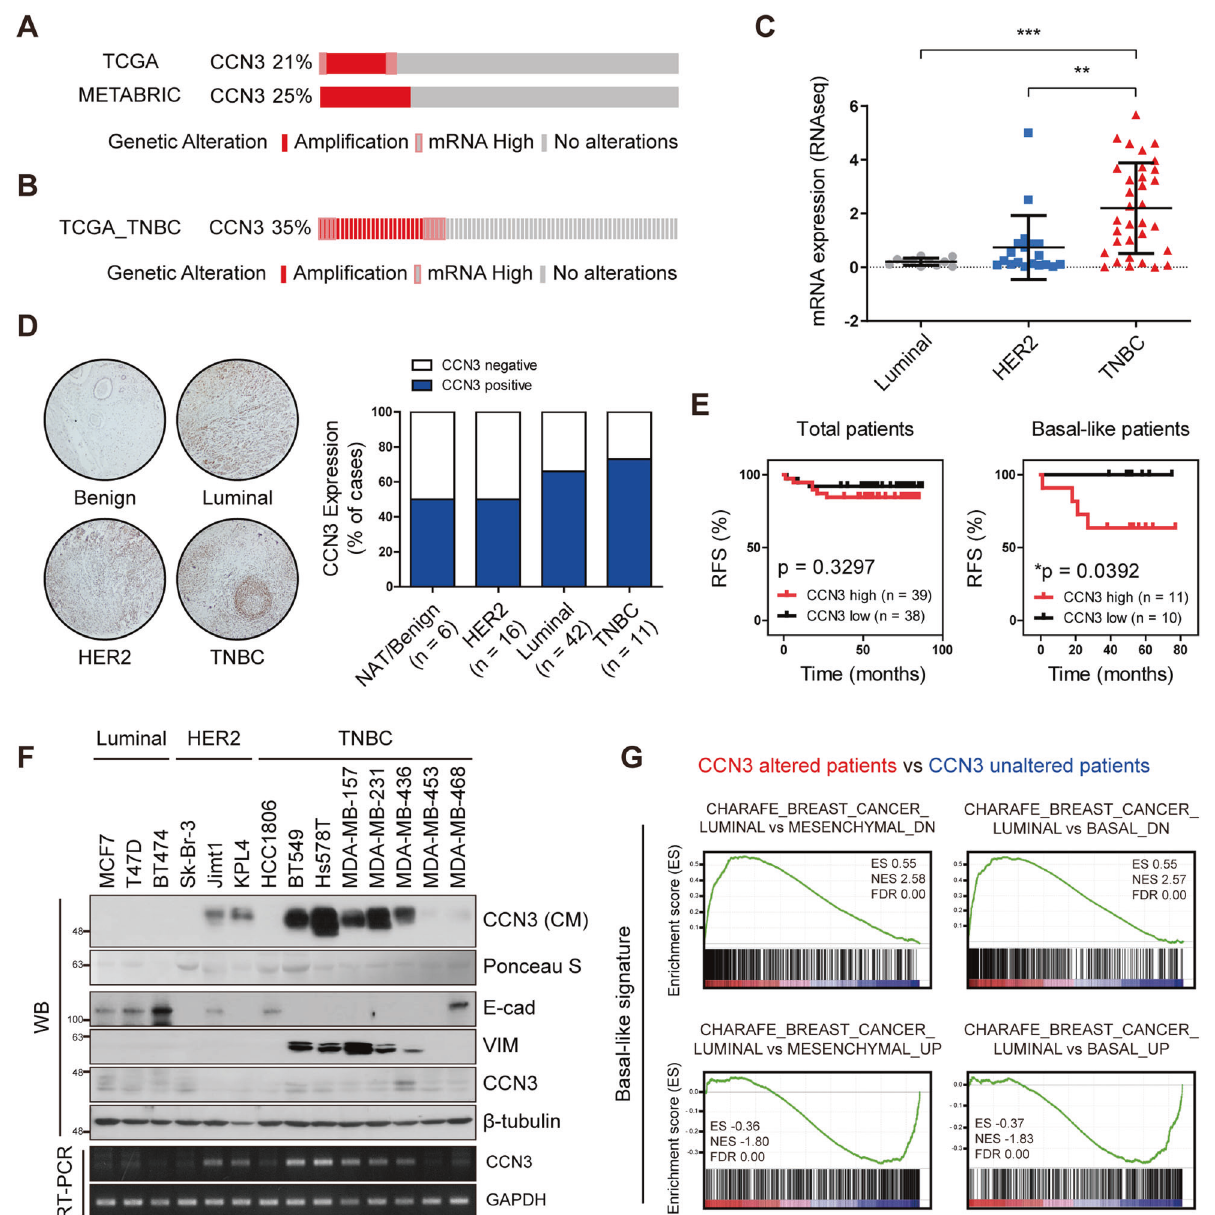
Fig. 1 CCN3 highly expressed in TNBC and correlates with basal-like phenotype. A Oncoprint of breast cancer patients with gene ampli fi cation and mRNA up-regulation of CCN3 from TCGA (Cell, 2015) and METABRIC dataset. B Oncoprint of triple-negative breast cancer patients with gene ampli fi cation and mRNA up-regulation of CCN3 from TCGA (Cell, 2015) dataset. C CCN3 mRNA expression of breast cancer cell lines. mRNA expression data were obtained from CCLE dataset. Expression values were clustered by breast cancer molecular subtype (luminal, n = 11; HER2, n = 19; TNBC, n = 33). P -values were calculated with one-way ANOVA with a post-hoc Dunnett ’ s multiple comparison test (* p < 0.05, ** p < 0.005). D Tissue array analysis of CCN3 expression with breast cancer patients. E Recurrence-free survival (RFS) plot of patients with CCN3 high versus low expression in GSE19615 dataset. P -values were calculated with log-rank test. F Western blot and RT-qPCR analysis of 14 breast cancer cell lines. Western blot analysis was assessed with whole cell lysate and precipitated protein from conditioned media. RT-qPCR analysis was assessed with cDNA of each cell line. β -tubulin was used as a loading control for whole cell lysate, and ponceau S staining intensity was used as a loading control for conditioned media. GAPDH was used as a loading control of RT-qPCR. G GSEA was performed with mRNA expression data from TNBC patients in the TCGA dataset (Cell, 2015). ES Enrichment score, NES Normalized enrichment score, FDR False discovery knockdown cell lines by western blot analysis. The results showed that phosphorylation of EGFR and its downstream signaling protein ERK were signi fi cantly decreased by CCN3